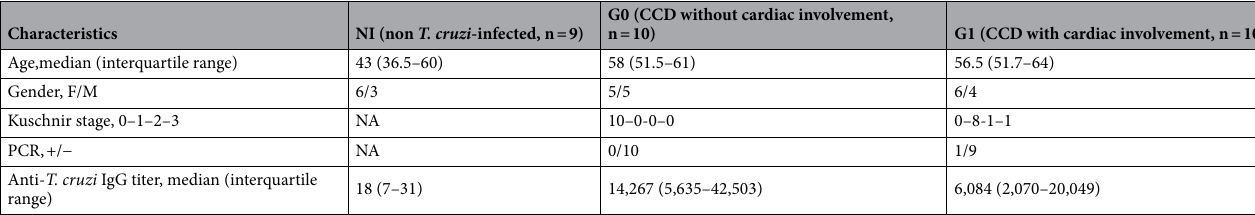
Table 1. Demographic and clinical features of the study population. All patients and non-infected donors were age- and gender- matched and clinical features are detailed. The titer of total anti- T. cruzi IgG antibodies was consider as the OD 50 sera dilution factor. NA not